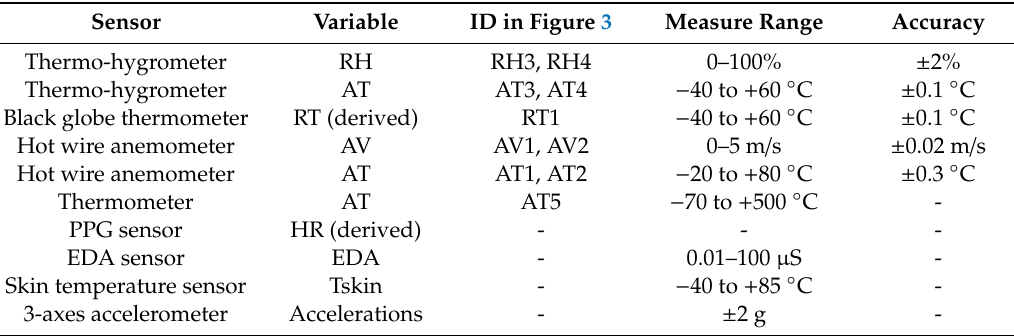
Table 1. Characteristics of sensors installed in the test cell. EDA: ElectroDermal Activity; HR: Heart Rate; PPG: Photoplethysmography; Tskin: skin temperature; RH: Relative Humidity; AT: Air Temperature; RT: Radiant Temperature; AV: Air